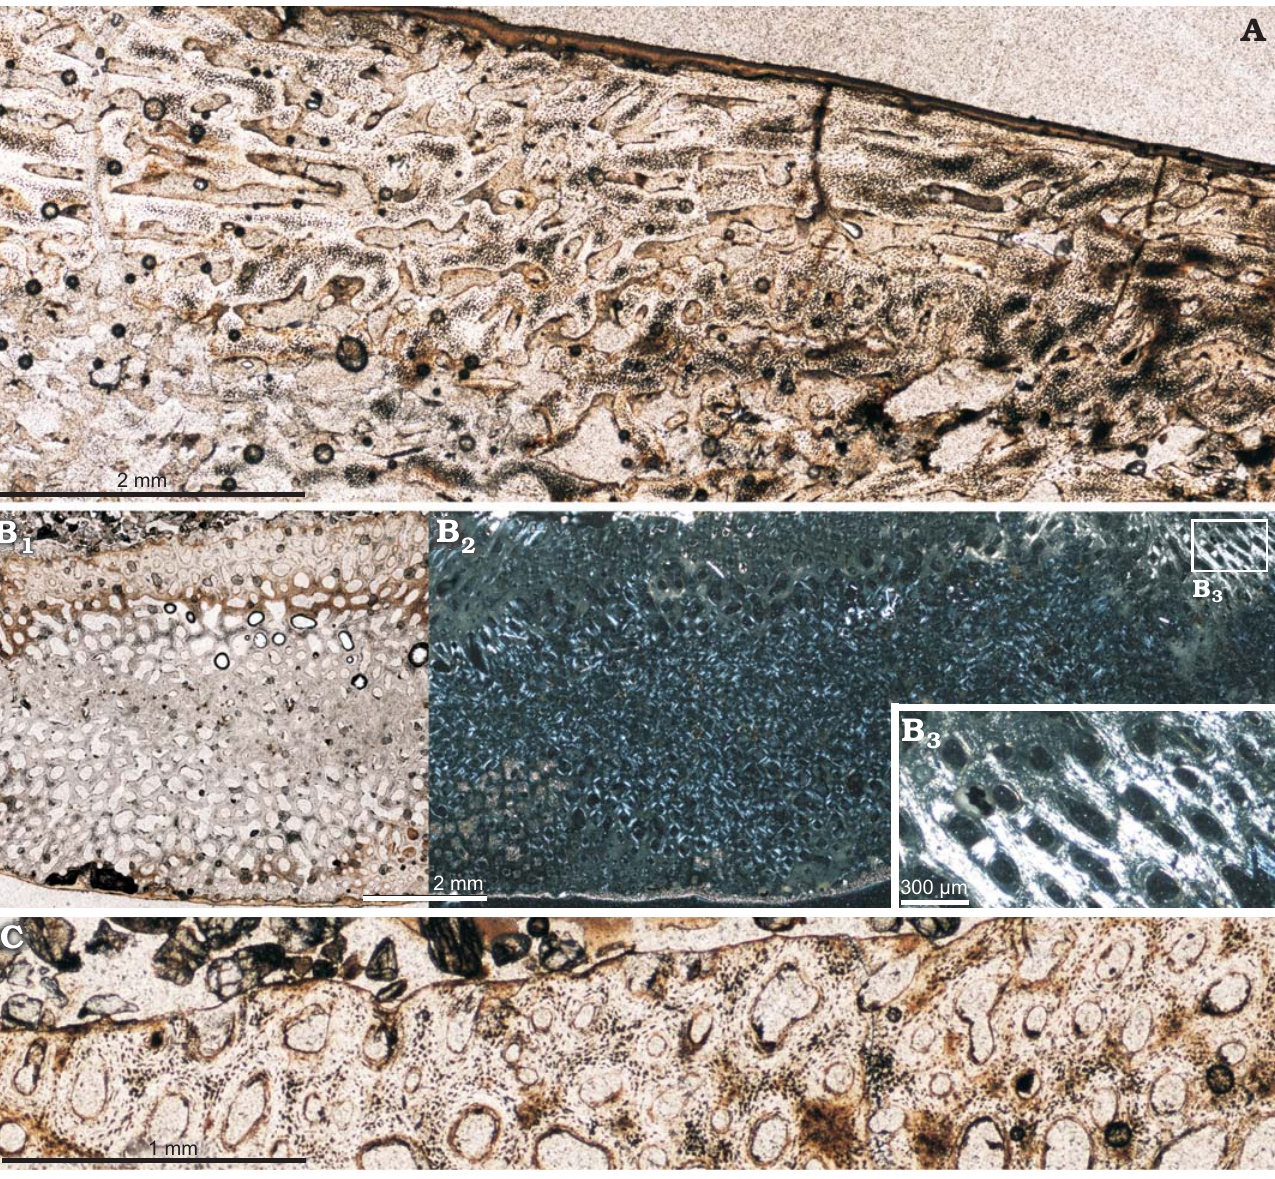
Fig. 5. Bone microstructure of the parietal frill in adult Protoceratops andrewsi Granger and Gregory, 1923, Bayn Dzak, Mongolia, Late Cretaceous (ZPAL MgD-II/33). A . Sagittal section. B , C . Transversal sections; note the condensations of the fossilized collagen fibers strengthening the porous tissue ( B ) and the formation of the small erosion lacunae at the external surface of the frill ( C ). A, B 1 , C, normal light; B 2 , B 3 , polarized